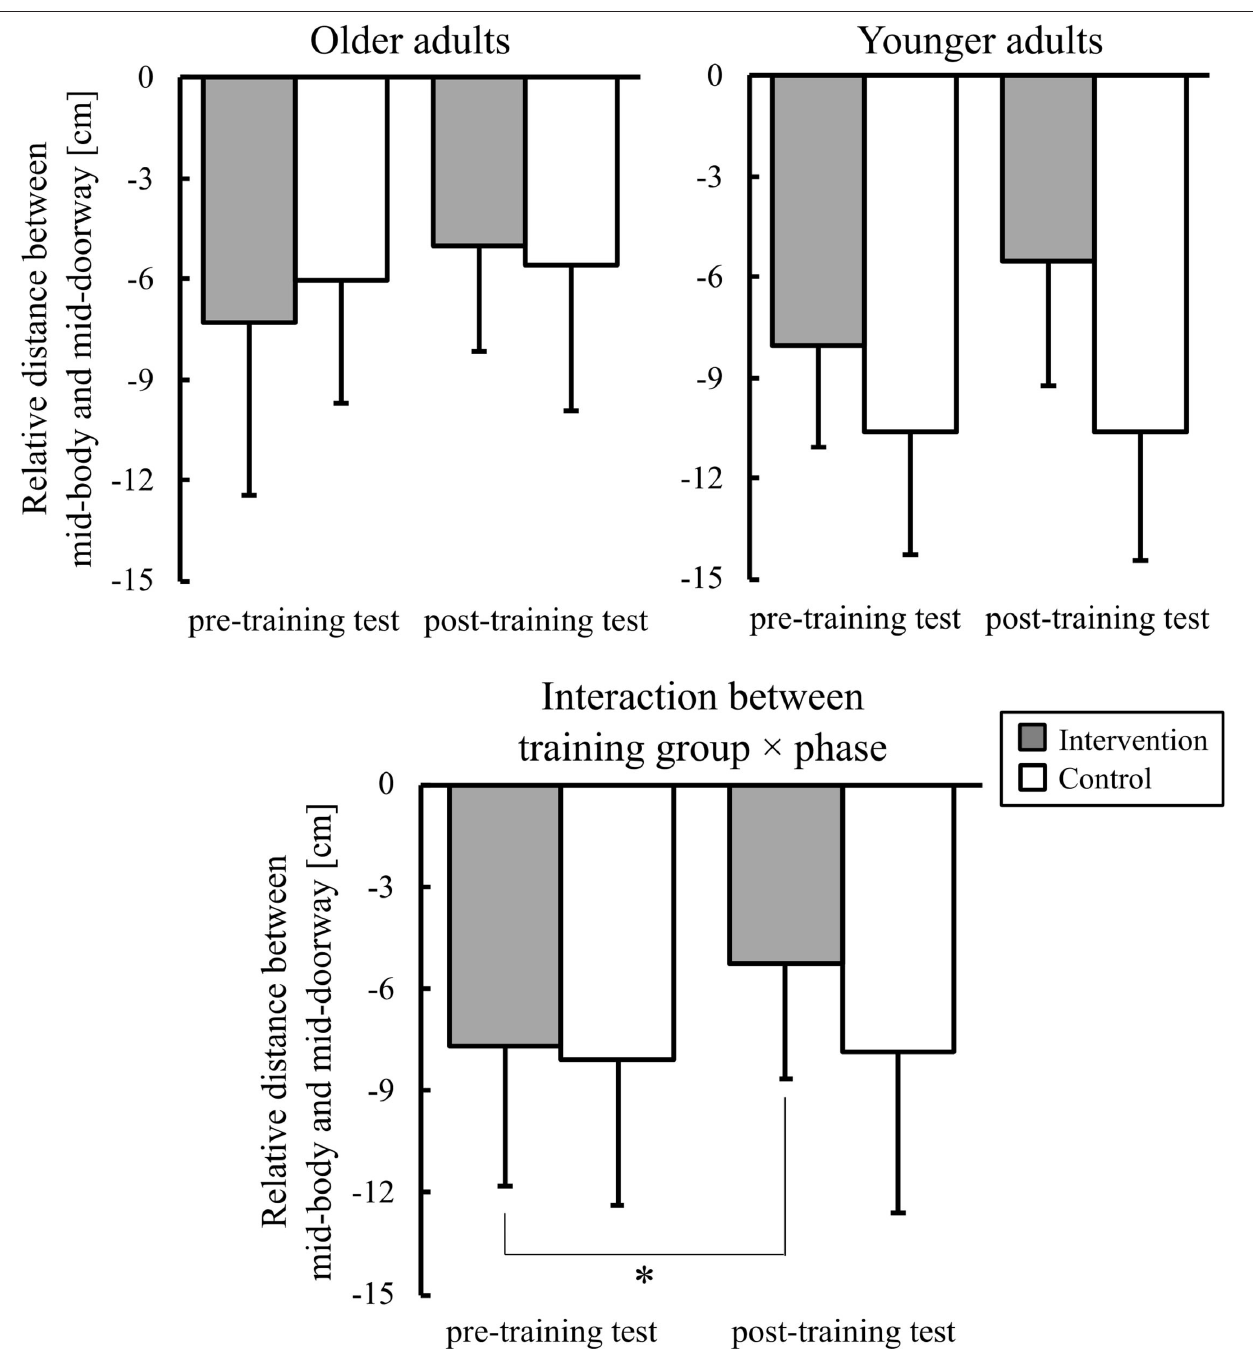
FIGURE 8 | Graphs of the relative distance between mid-body and mid-doorway. Error bars represent the standard deviation among participants. * indicates the significant difference.